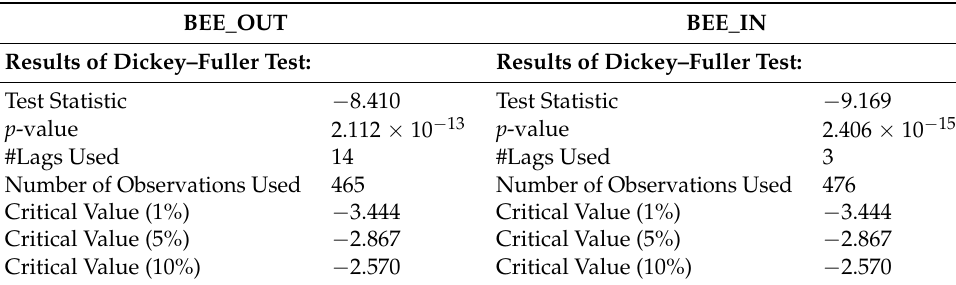
Table 2. Results of Dickey–Fuller